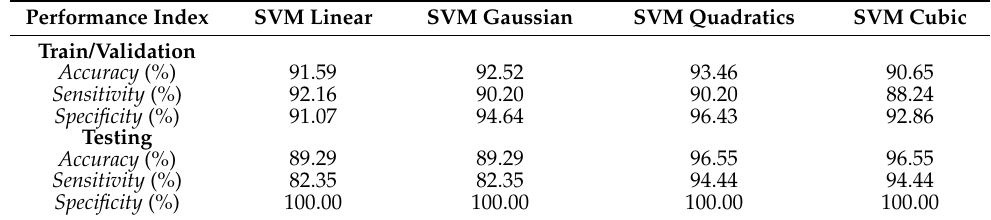
Table 3. Classifier performance assessment result of four different SVM kernel